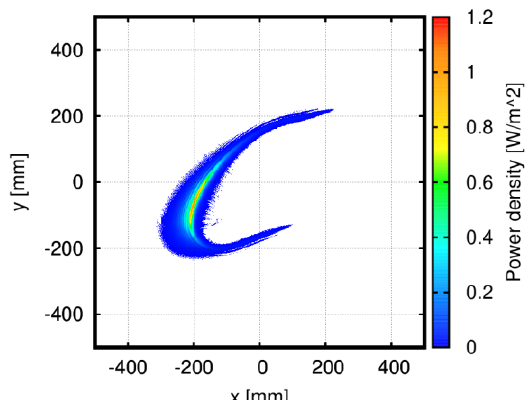
Fig. 13. Spill-over power of the beam U1 100 mm behind the plane of the mirror UA.